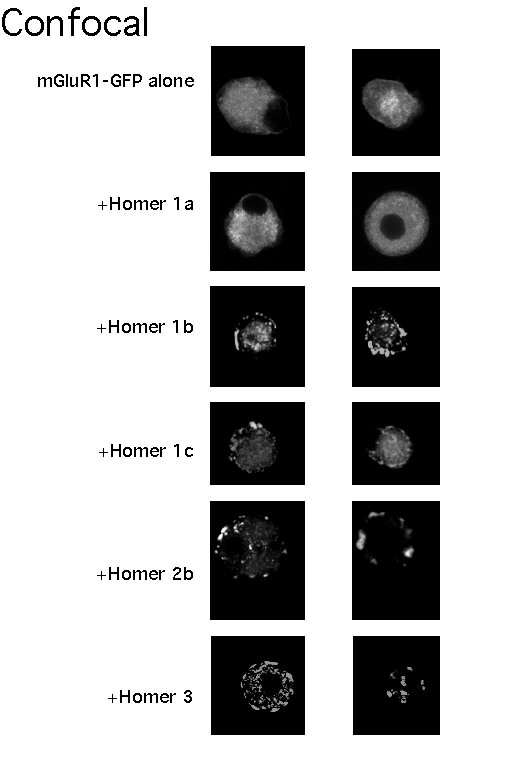
Confocal images of mGluR1-GFP fluorescence in SCG neurons expressing the receptor alone, "mGluR1-GFP", or with co-expression of the indicated Homer protein. Two representative neurons from each group are shown. The total number of neurons examined for each group were: mGluR1-GFP (26 cells), + Homer 1a (9), + Homer 1b (12), + Homer 1c (12), + Homer 2b (34), + Homer 3 (7).